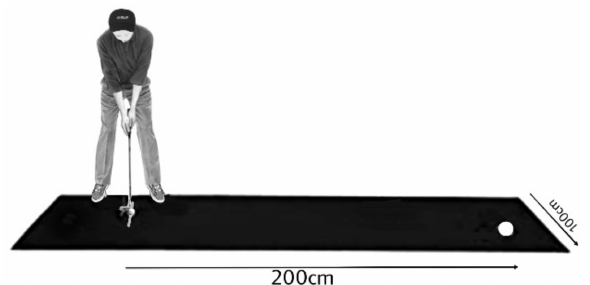
Figure 2. The schematic illustration of the golf putting